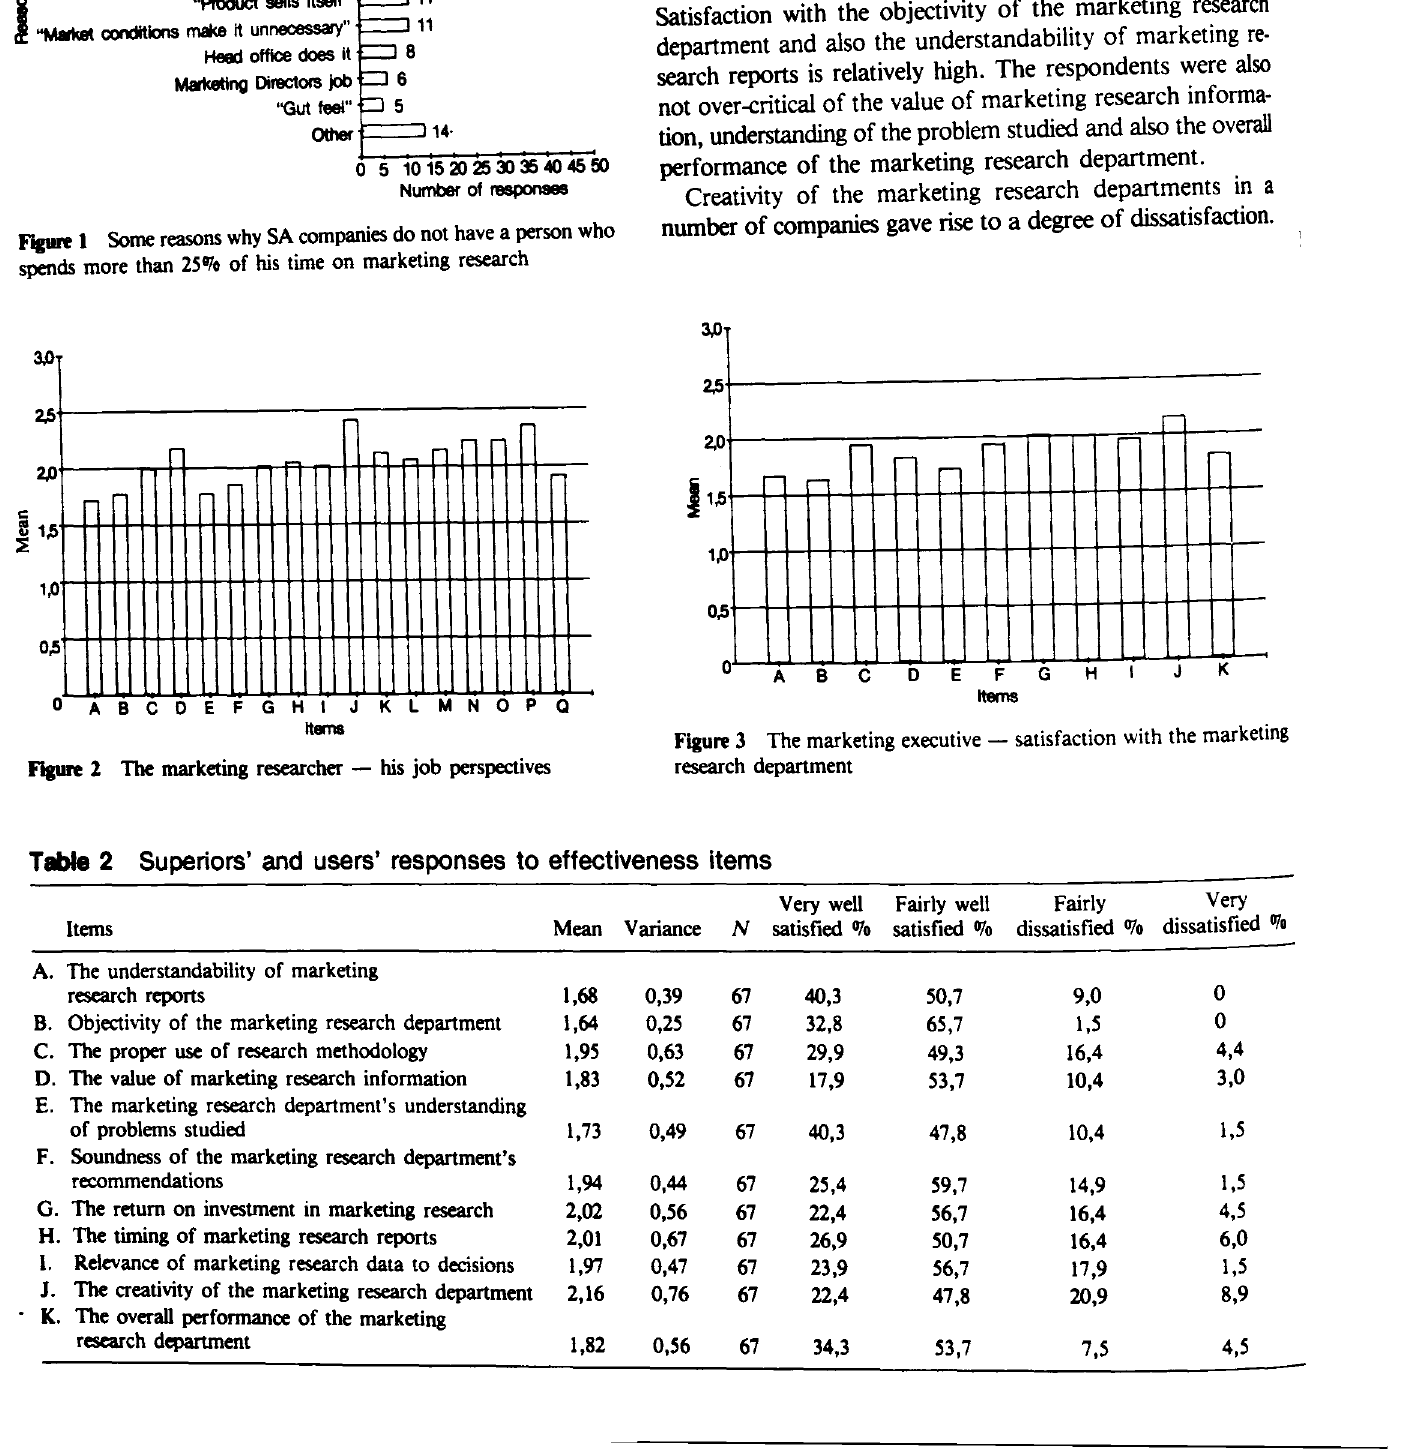
Figure 2 The marketing researcher - his job perspectives